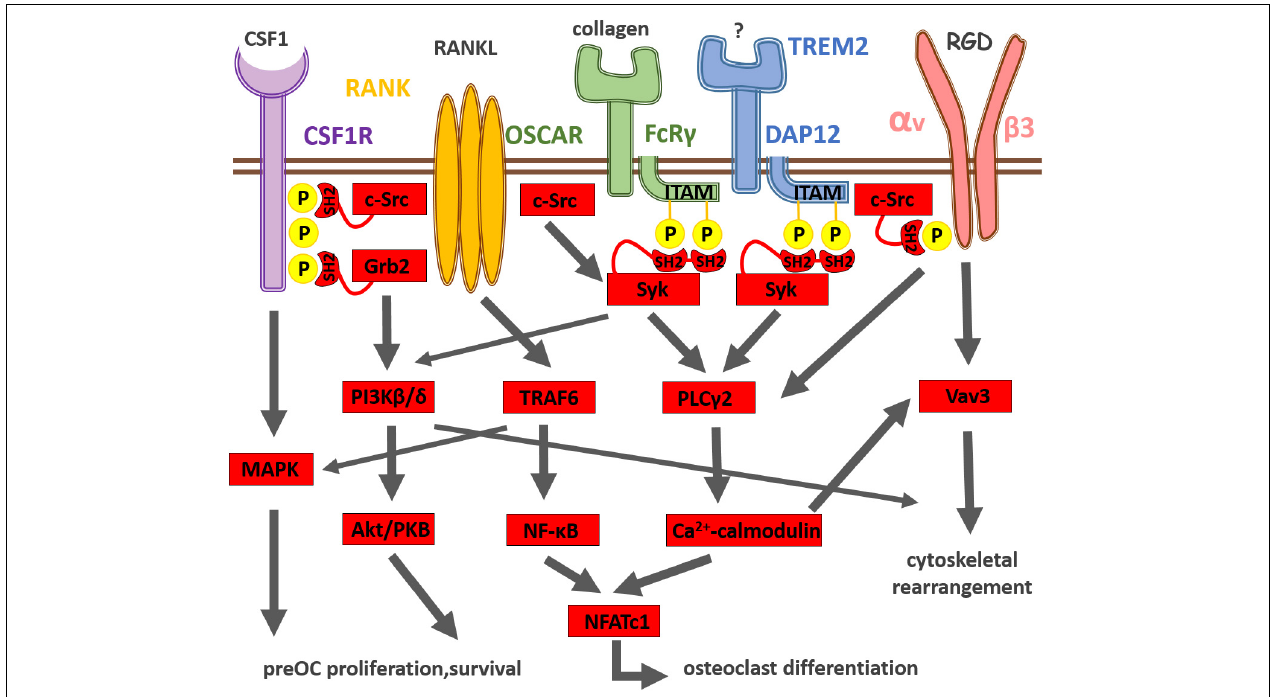
FIGURE 1 | Summary of osteoclast differentiation induced by integration of CSF-1R, RANK, immunoreceptor-like and integrin receptor signaling. CSF-1 and its receptor CSF-1R activate the MAPK cascade pathway leading to the survival and proliferation of preosteoclasts. RANKL and its receptor RANK transduce signals via the adaptor molecule TRAF6, which activates the NF- κ B and MAPK pathways leading to the differentiation of osteoclasts. The expression of the master regulator of osteoclastogenesis, NFATc1, is driven by NF- κ B and NFATc1. The activation of NFATc1 is also regulated by the costimulatory signaling pathways, where FcR γ , DAP12 and their associating partners (OSCAR and TREM2, respectively) recruit Syk, which further activates PLC γ 2, resulting in the activation of calcium signaling. The calcium signaling activates then calcineurin, which in turn promotes NFATc1 expression. The calcium signal also induces Vav3 activation involved in α v β 3 integrin signaling, which leads to cytoskeletal reorganization and osteoclastic bone